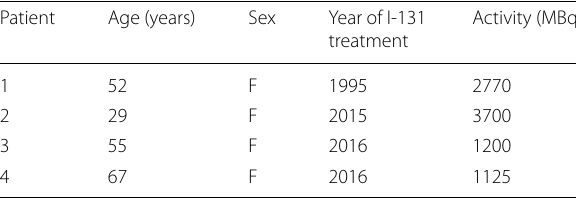
Table 3 Patient characteristics for iodine